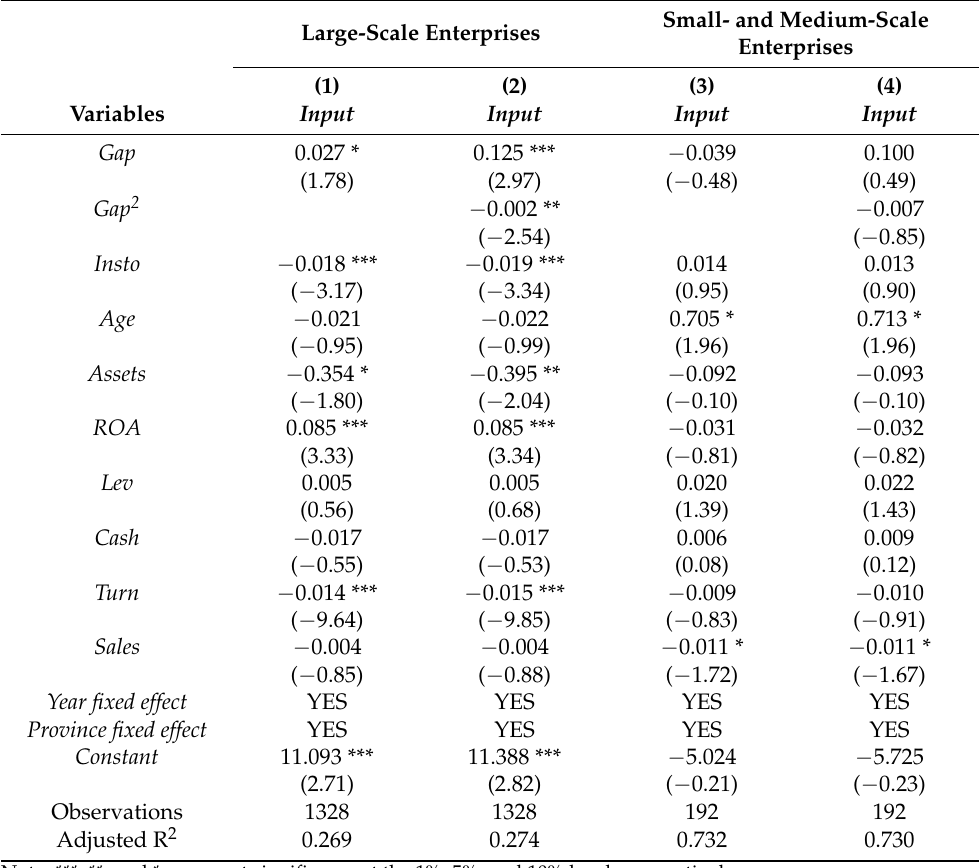
Table 7. Heterogeneity test: large-scale enterprises vs. small- and medium-scale enterprises. Small- and Medium-Scale Large-Scale Enterprises